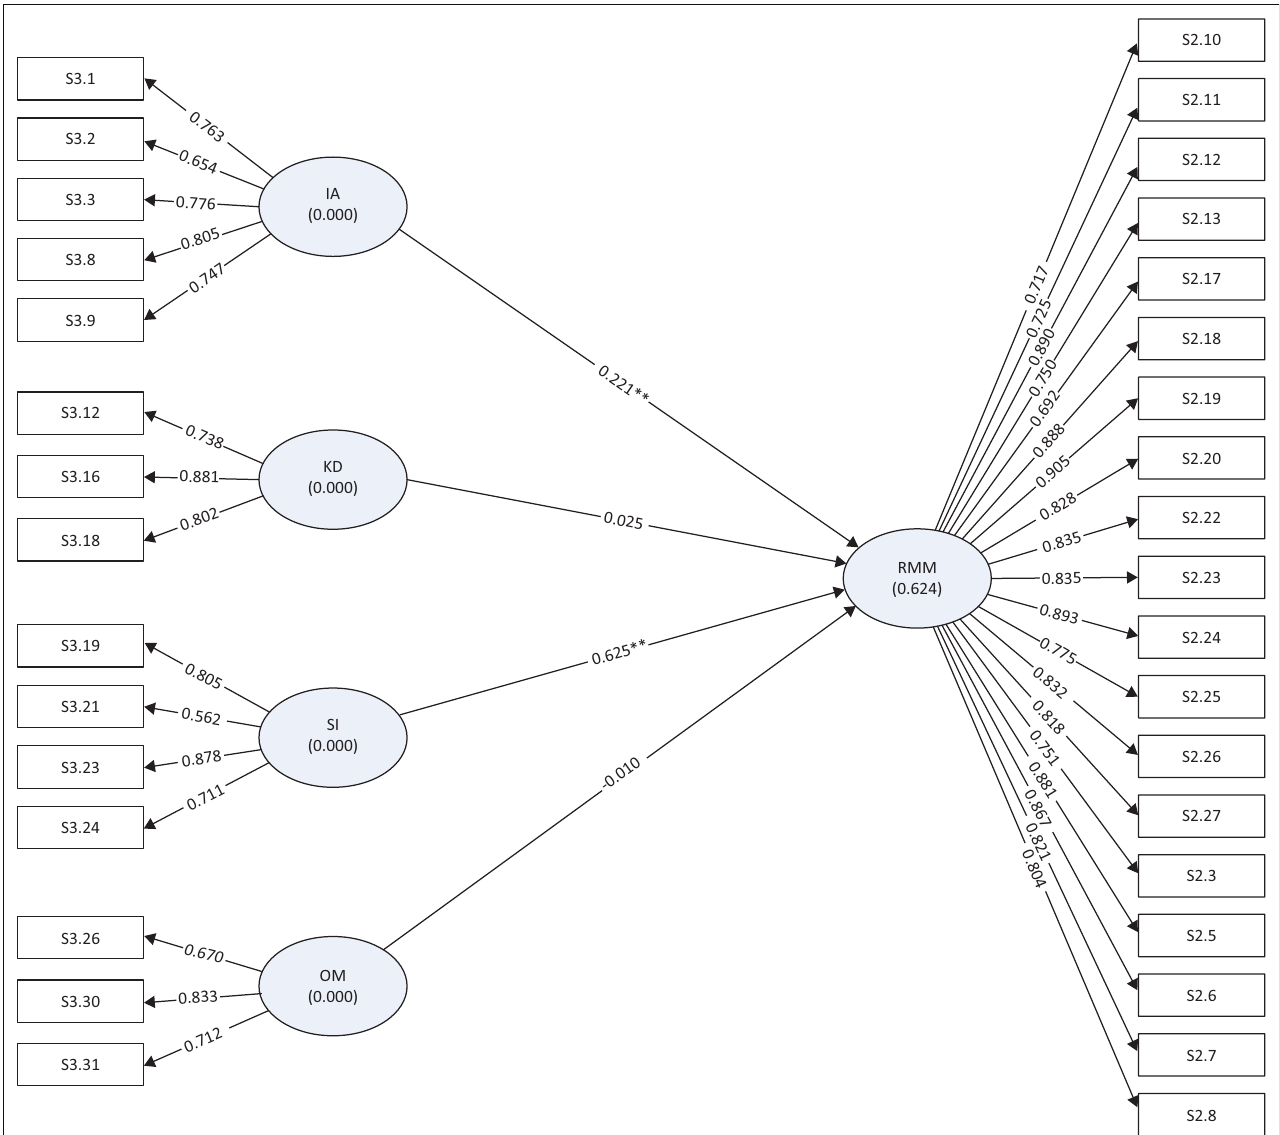
FIGURE 2: Influence of organisational learning components on risk management maturity. Values between parentheses indicate R 2 . The symbol ‘**’ indicates a significant level at p < 0.01. The full list of indicators’ names is presented in Box